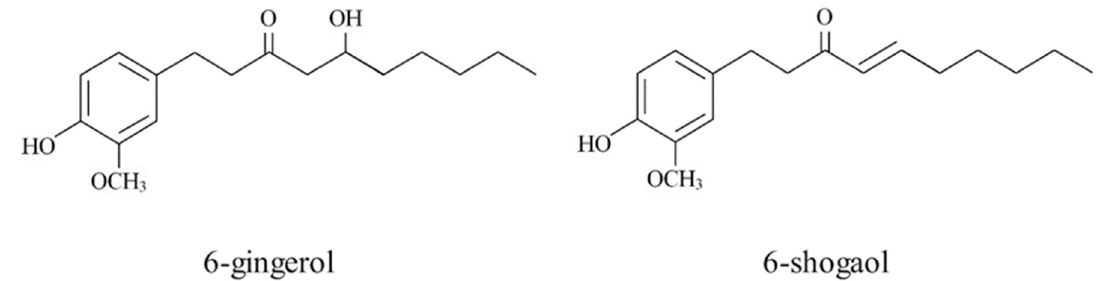
Figure 1. Chemical structure of the two most abundant non-volatile phenolic compounds (6-gingerol and 6-shogaol) in ginger.